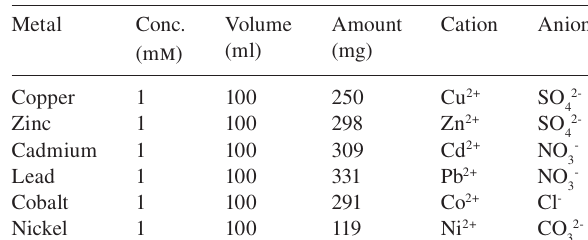
Table 1 Metal ion solutions used in the study, and anions and cations in the medium.